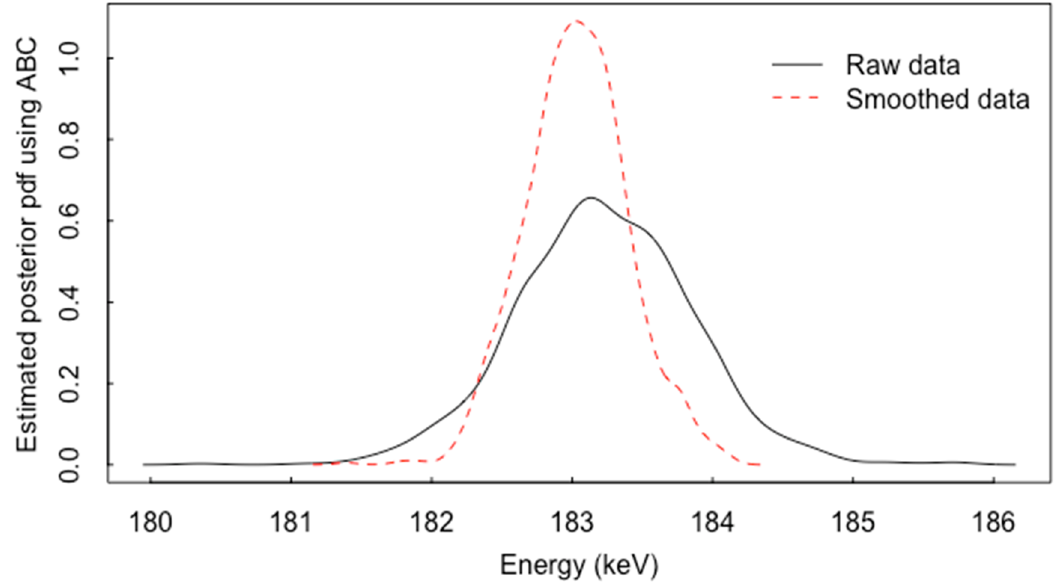
Figure 8. ABC-based (Approximate Bayesian Computation) estimate of the posterior probability density function (pdf) for peak location using raw and smoothed data.